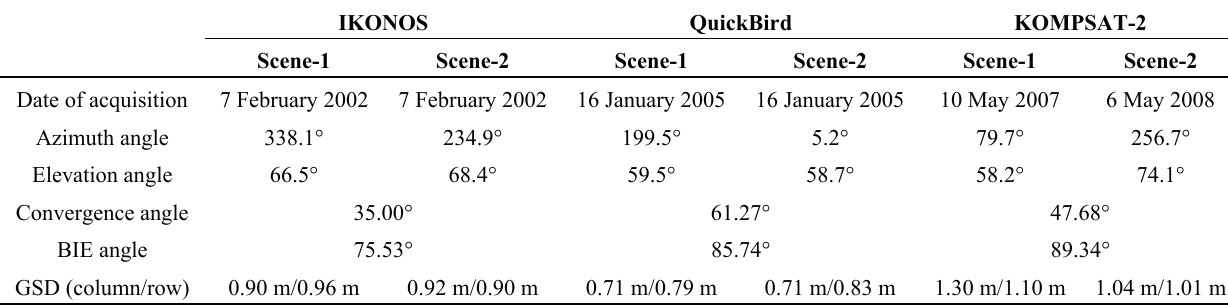
Figure 1. Representation of convergence and BIE angles on stereo geometry. Table 1. Properties of experimental